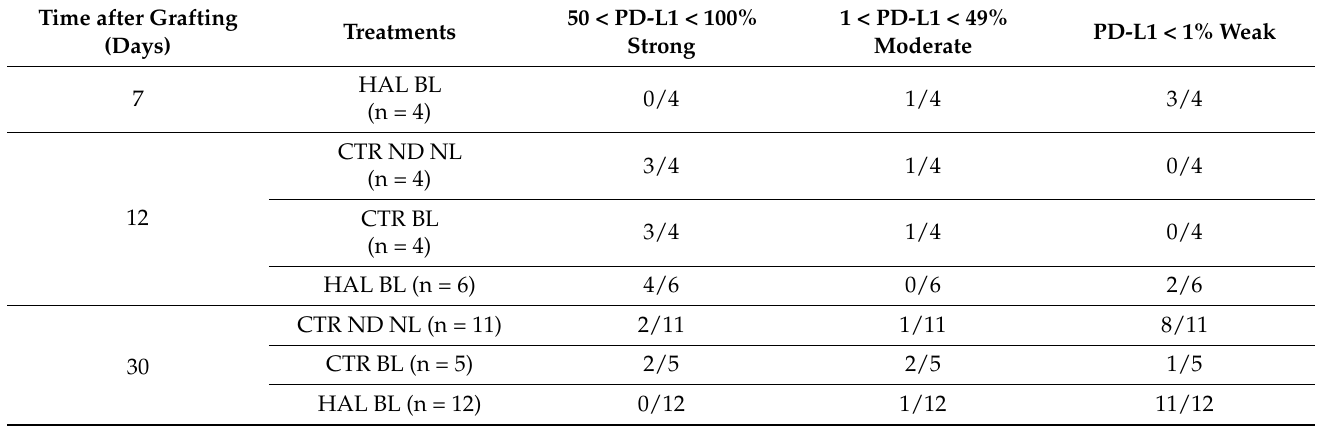
Table 3. IHC-assessed PD-L1 expression at 7, 12, and 30 days after tumor inoculation in control (CTR ND NL, CTR BL) and HAL BL-treated bladder tumors.